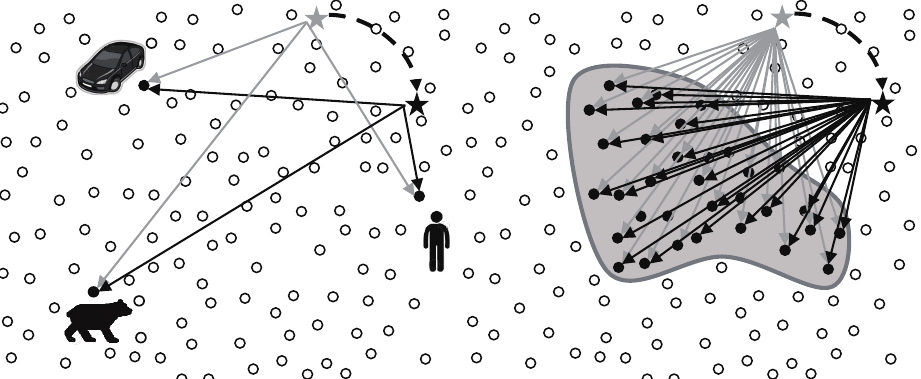
Figure 3. Location update of a mobile sink in individual object tracking and continuous object tracking: ( left ) Individual location update and ( right ) Integrated location